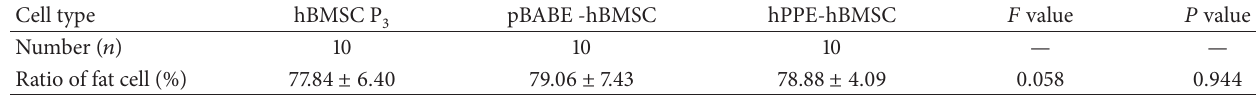
Table 3: Proportion of adipocytes after adipoinduction for 3 weeks (%, 𝑋 ± SD).